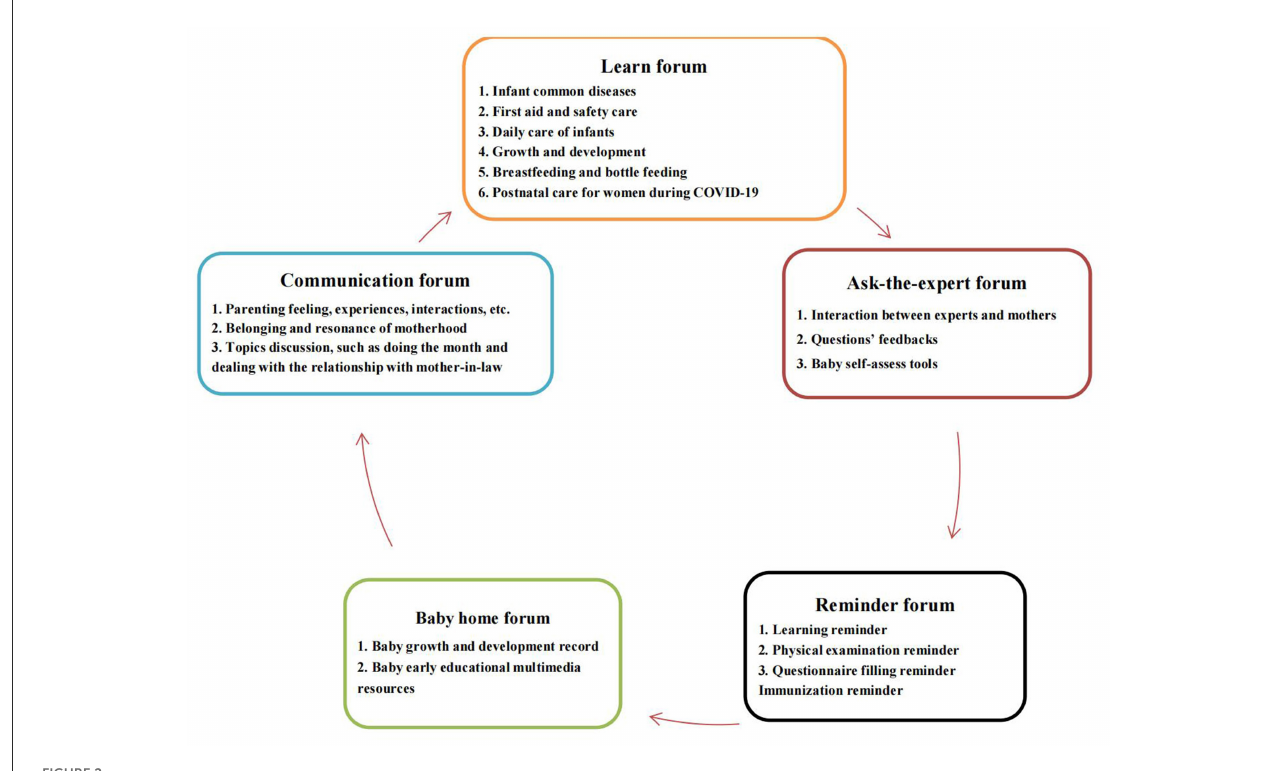
FIGURE2 Contents of the ISP.